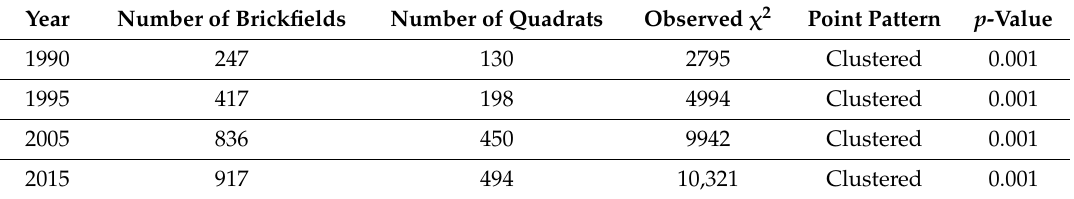
Table 2. Results of the quadrat analysis reveals that brickfield locations are clustered.